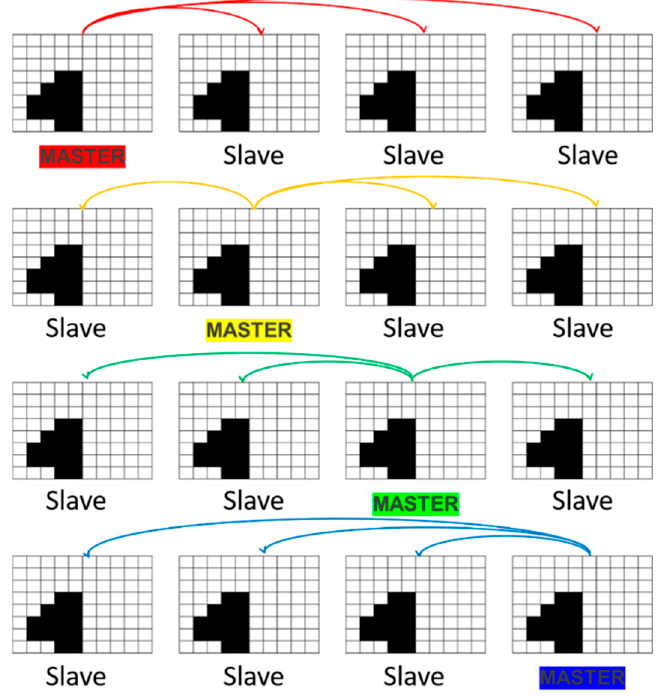
Figure 1. Progressive correlation scheme used to achieve the fully redundant stack of correlation maps (Multimaster Analysis) [31].